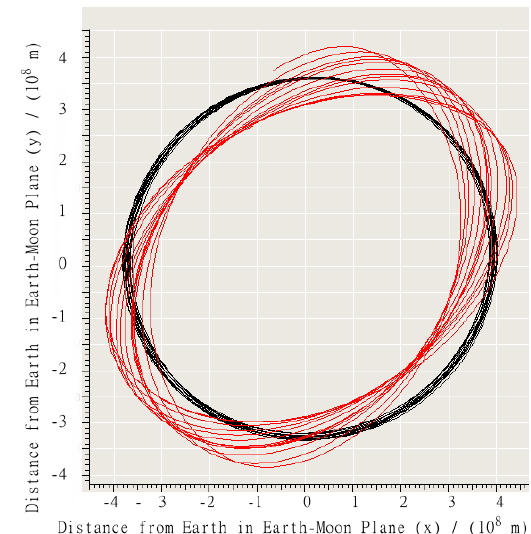
Figure 3. A slowly precessing 1:1:2 resonance. The black line (circular trajectory) represents the lunar orbit relative to the Earth-centered inertial-frame, and the red line (precessing oval trajectory) the Distant Retrograde Orbit (DRO) trajectory relative to the Earth-centered inertial frame. Earth is at plot-center.